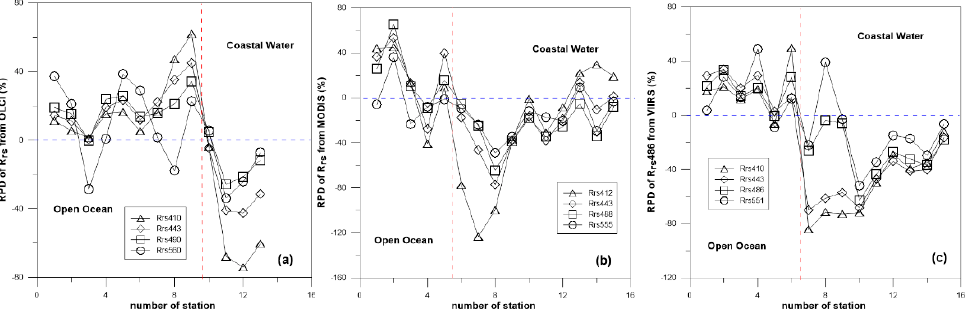
Figure 9. RPD of 𝑅 (cid:3045)(cid:3046) at each station from OLCI ( a ), MODIS ( b ), VIIRS ( c ). The vertical red dashed line shows the limit between the open and coastal waters. shows the limit between the open and coastal